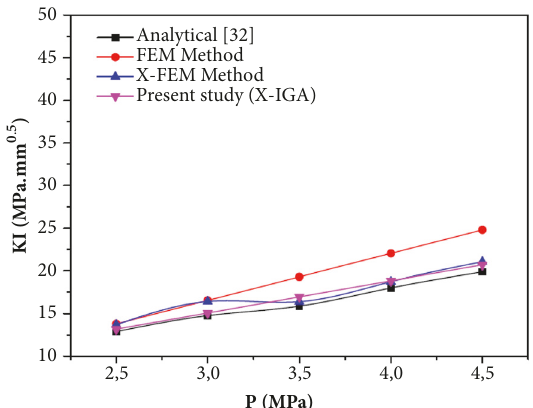
Figure 6: The variation of the Stress Intensity Factors with crack length for different crack